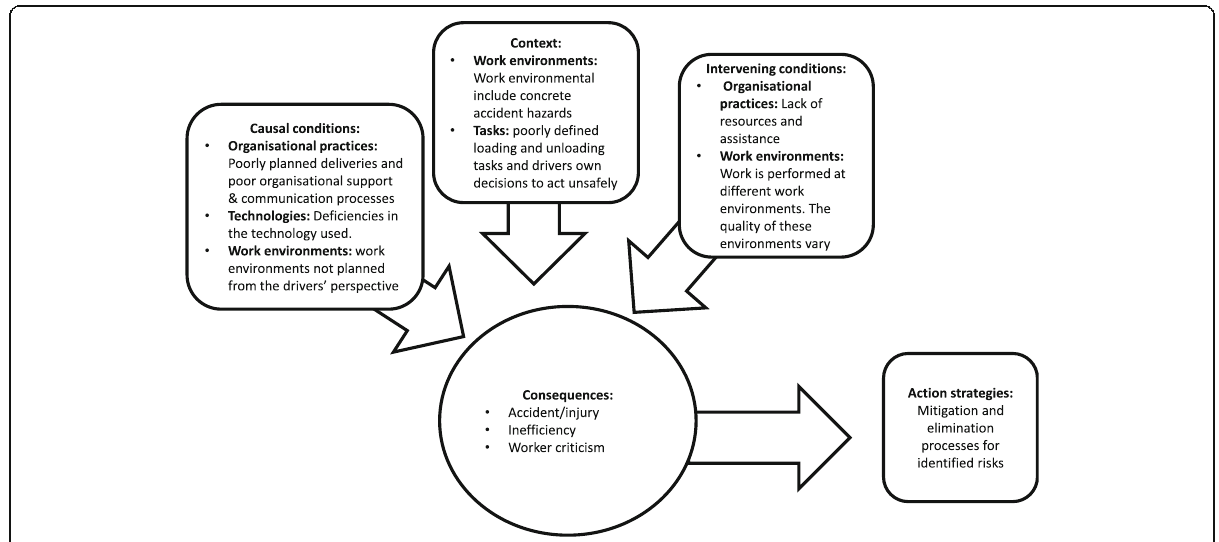
Fig. 2 The risk management model for psychosocial